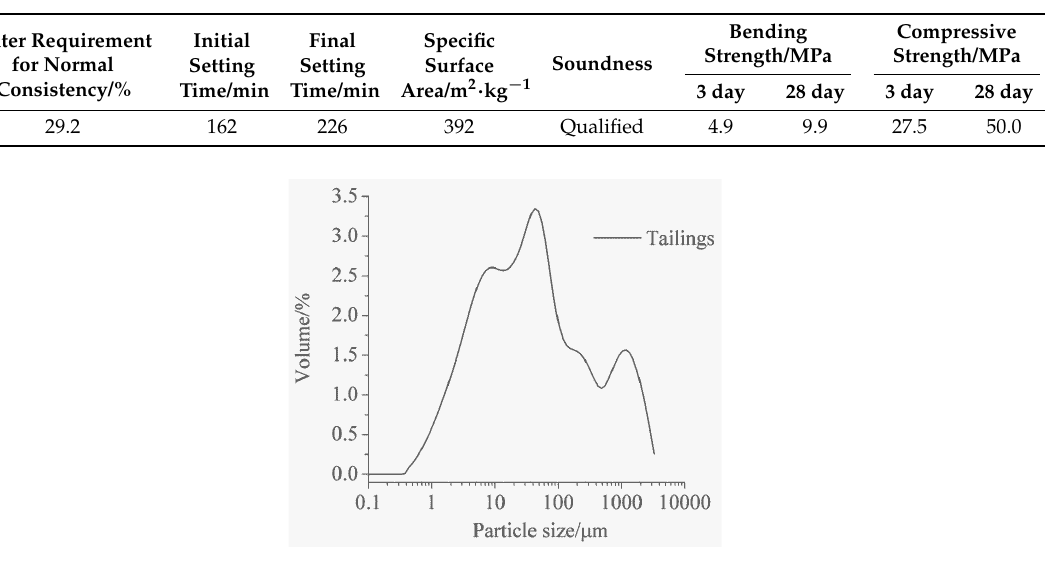
Table 1. Main properties of cement.